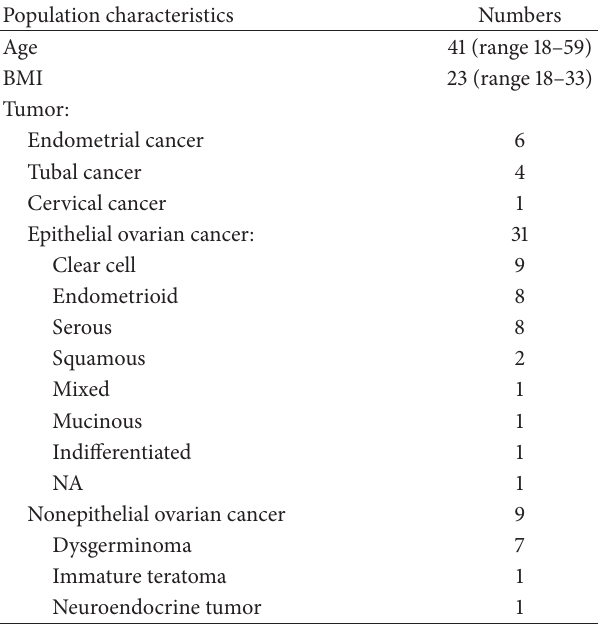
Table 1: Patients characteristics and